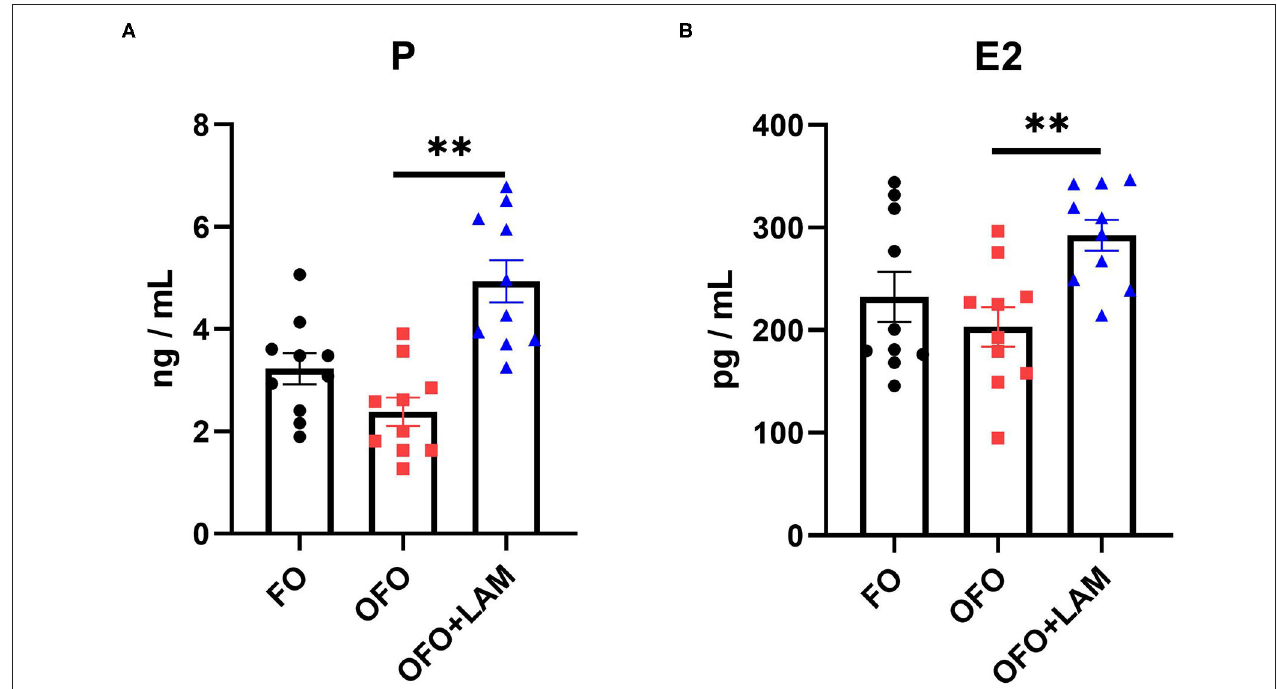
FIGURE 3 | The effect of FO, OFO, and OFO with LAM on serum hormone levels. (A) The level of progesterone in FO, OFO, and OFO + LAM; (B) the level of estradiol in FO, OFO, and OFO + LAM. ** p < 0.01 indicate significant differences between the two